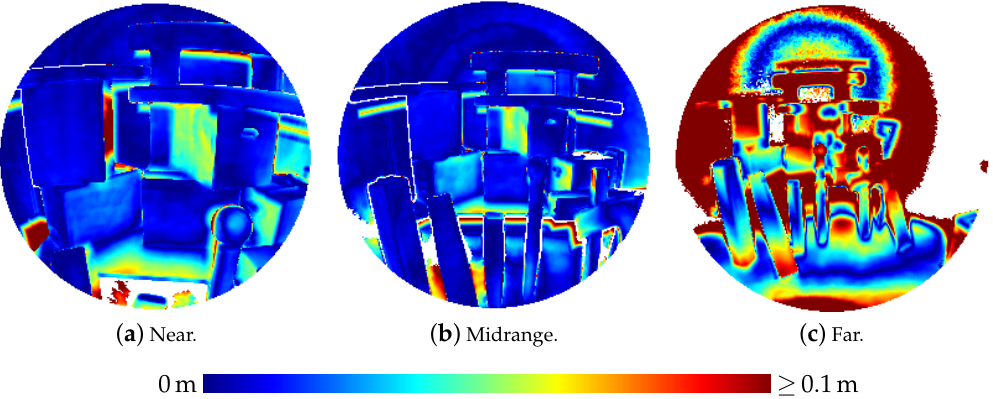
Figure 11. Accuracy of HoloLens range measurements evaluated against TLS ground truth data for the three-dimensional scene depicted in Figure 5 captured from three different distances.